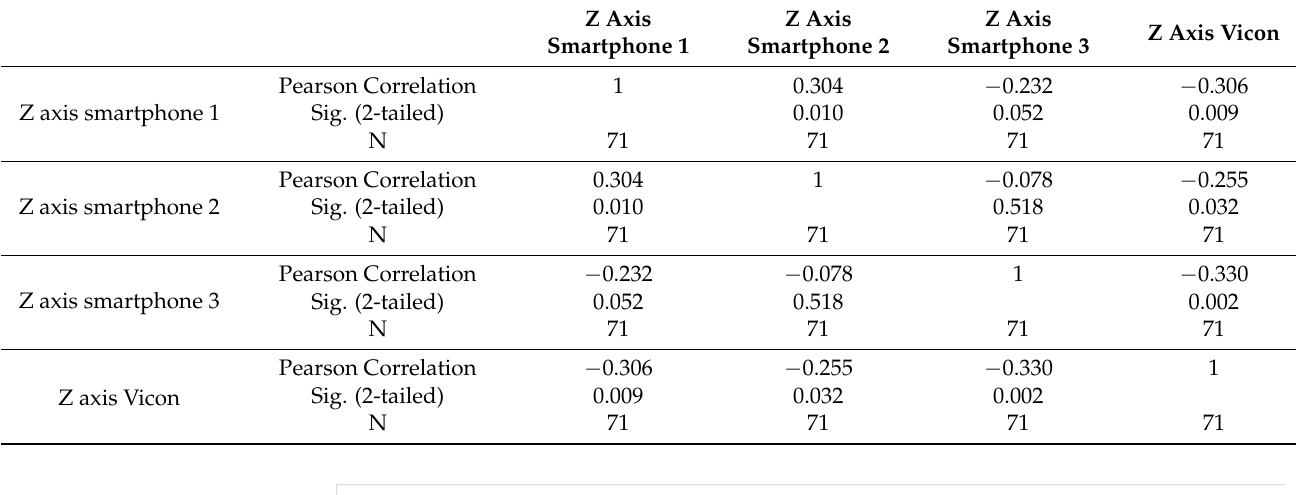
Figure 7. Pearson r correlations from each device linear acceleration’s data on the Y axis. Referring to linear acceleration data from each device on the Z axis, Pearson’s correlation coefficient (r) showed significant correlations between (a) Smartphone 1 and Vicon system (Pearson r = − 0.306, sig = 0.009), (b) Smartphone 2 and Vicon system (Pearson r = − 0.255, sig = 0.032) and (c) Smartphone 3 and Vicon system (Pearson r = − 0.330, sig = 0.002). Pearson r correlation from each device linear acceleration’s data on the Z axis are depicted in Table 5 and Figure 8. Table 5. Pearson r correlations from each device linear acceleration’s data on the Z axis.